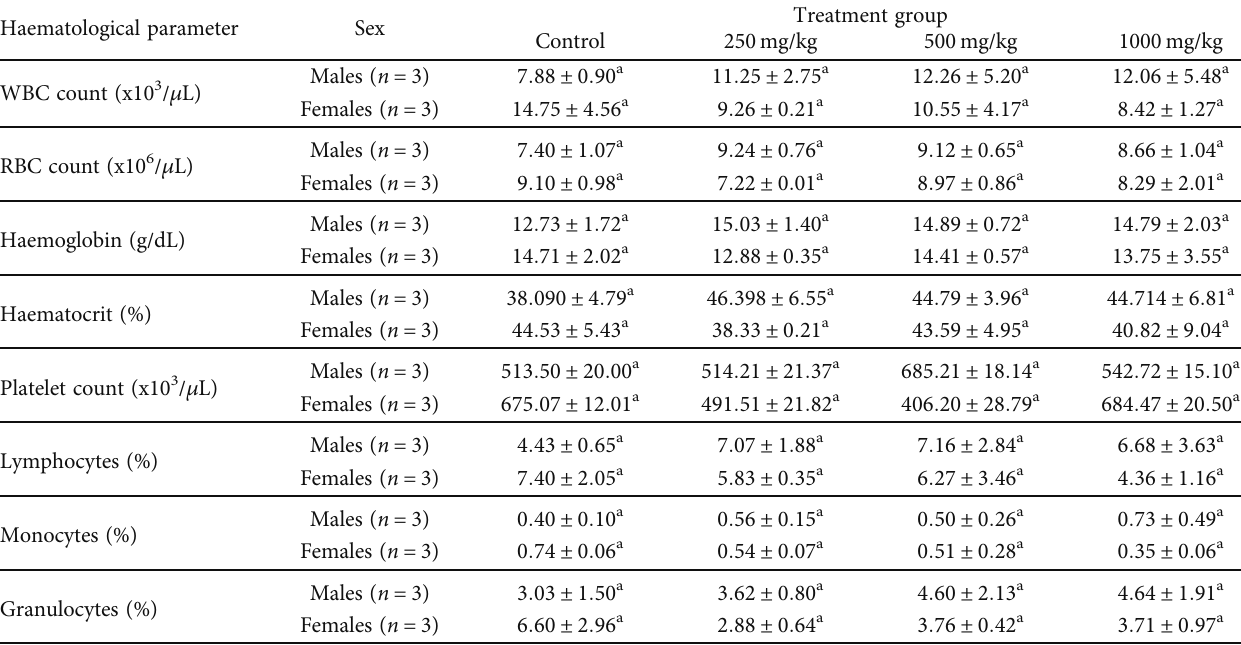
Values are expressed as mean ± SEM . n = 3 females, n = 3 males. In each sex, the haematological parameters of the treated groups are compared to the control (ANOVA followed by multiple comparison test of Dunnett). The values sharing any one common superscript in the same row do not di ff er ( p > 0 : 05 ). WBC: White Blood Cell Count, RBC: Red blood cell